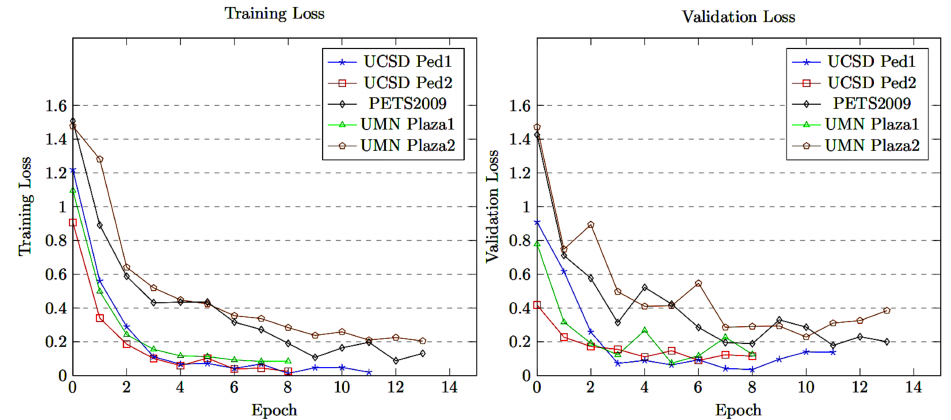
Figure 8. Training and validation loss of MCMS-BCNN-Attention + Efficientnetv2.